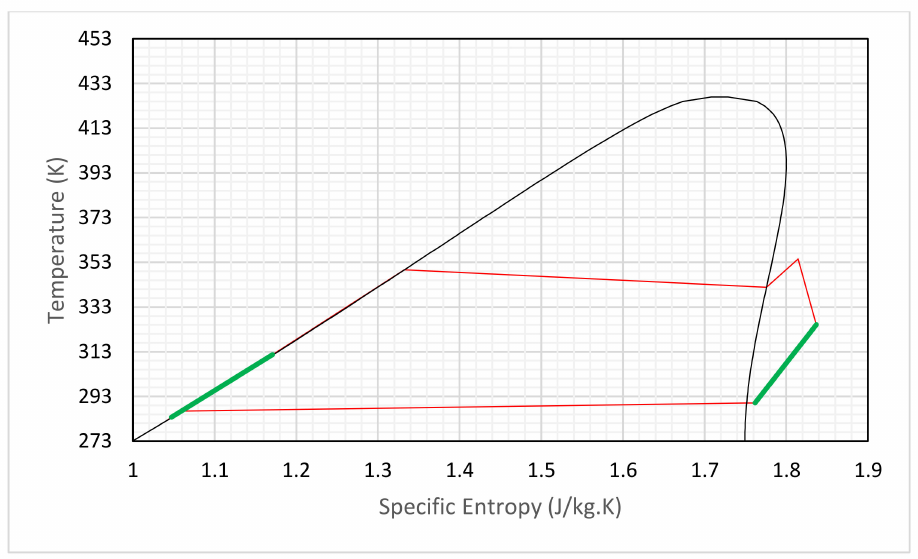
Figure 2. T-s diagram of the highest e ffi ciency case. Regenerative portions of the cycle shown in